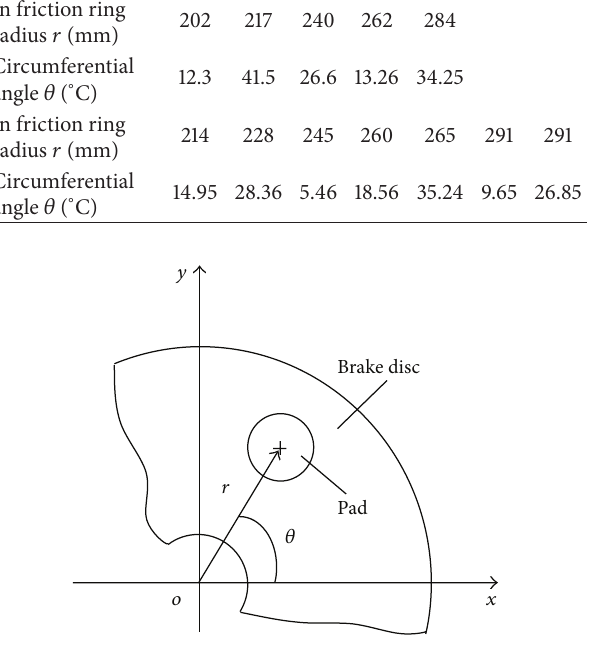
Figure 9: Diagram of friction pair.